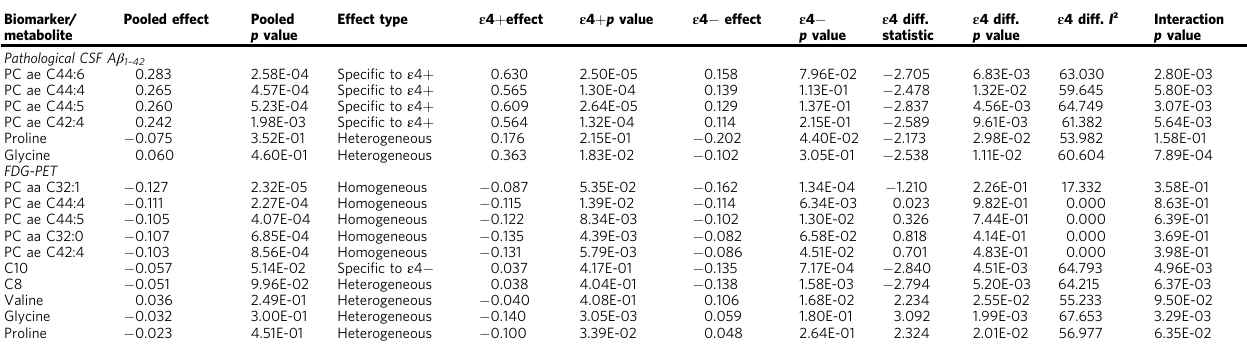
Table 3 Association results and heterogeneity estimates for metabolites in relation to A-T-N biomarkers strati fi ed by APOE ε 4 status.